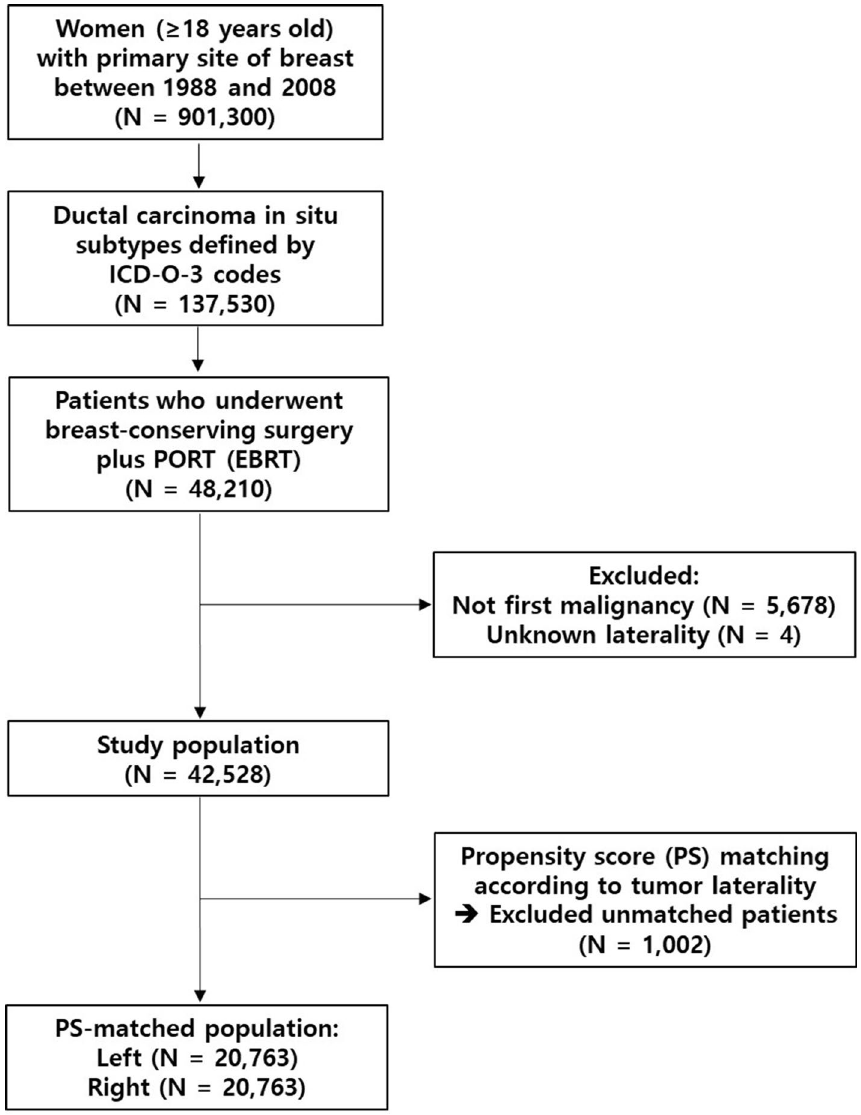
Figure 3. Flowchart of patient selection. PORT: postoperative radiotherapy; EBRT: external beam radiotherapy; PS: propensity